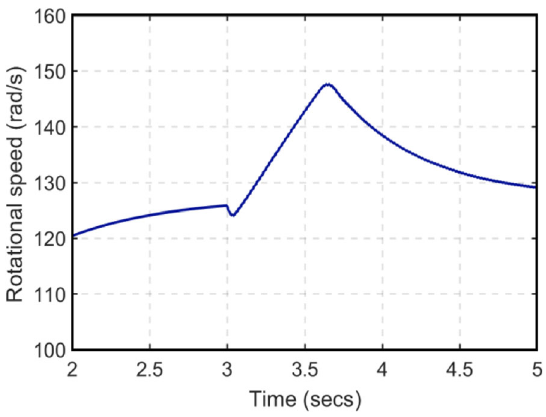
Fig. 17 Evolution of the d component of the